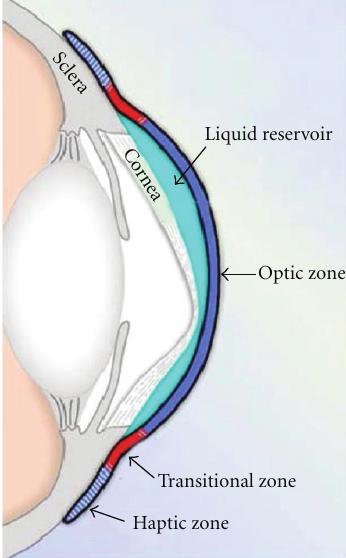
Figure 2: Schematic diagram of a PROSE device fitted to an eye with corneal